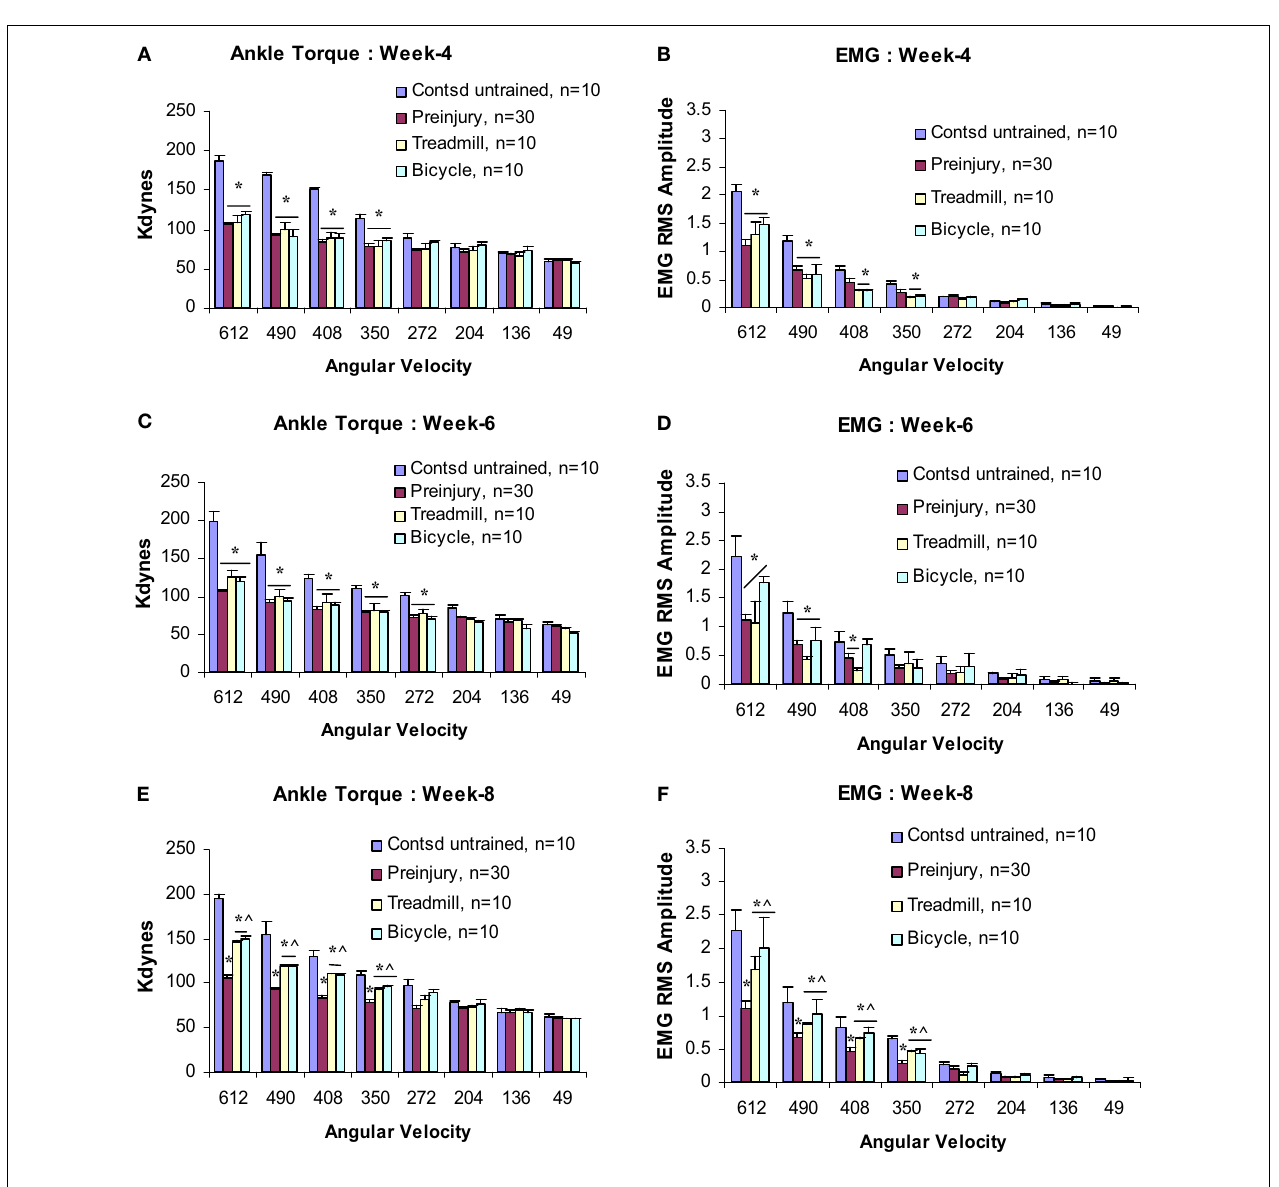
FIGURE 3 |Velocity-dependent ankle torque (A,C,E) and time-locked EMG-RMS magnitude (B,D,F) of postcontusion weeks 4–8. Note,